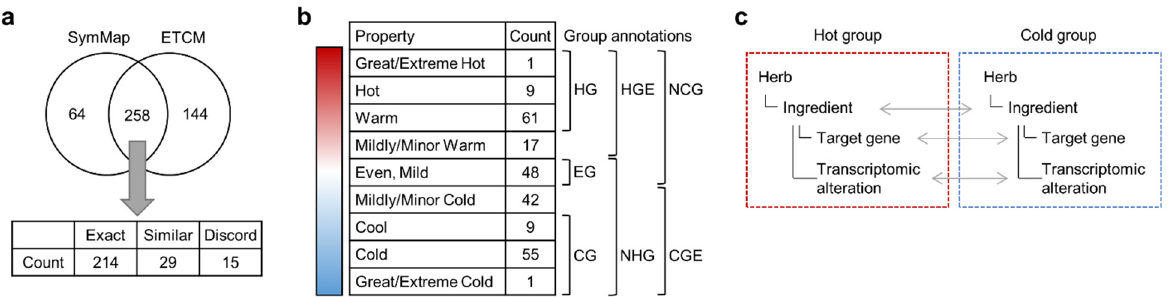
Figure 1. Integration of databases for the analysis of hot and cold herbs. ( a ) Comparison of herbs and their cold/hot properties obtained from the following two databases: SymMap and ETCM. ( b ) Summary table of integrated properties of 243 herbs that were similar or exact matches. Herbs were classified as a hot group (HG), cold group (CG), or even group (EG) based on their properties. Herbs were further classified as hot group extended (HGE), non-hot group (NHG), cold group extended (CGE), or none-cold group (NCG). The counts represent the number of herbs classified into each group. ( c ) Comparison of hot and cold groups at different